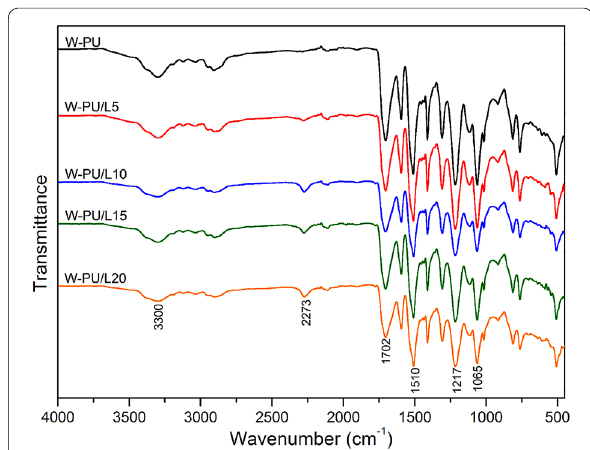
Fig. 3 FTIR spectra of the W–PU foams containing varying